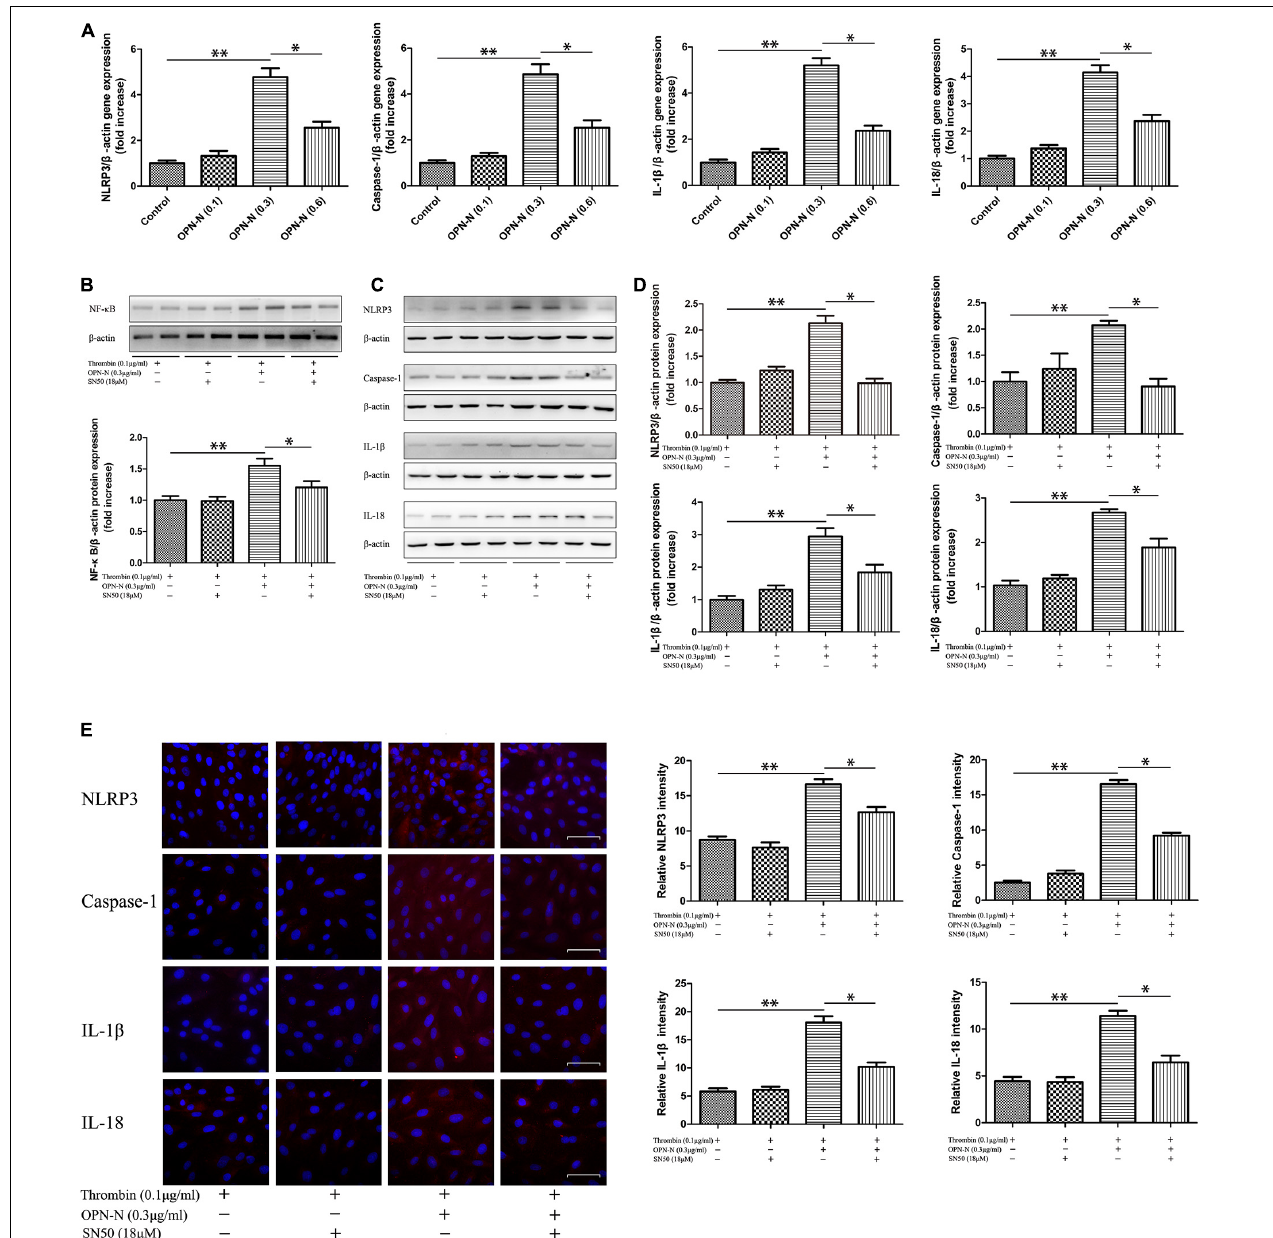
FIGURE 8 | OPN-N had a causal link of pyroptosis and inflammation through NF-KB mediated signaling pathways in VSMCs. (A) qPCR analyses of the mRNA expression level of NLRP3, Caspase-1, IL-1 β , and IL-18 at different OPN-N concentrations. (B) Western blotting analyses of the protein levels of NF- κ B in VSMCs, and quantification of NF- κ B protein expression. (C,D) Western blotting analyses of the protein levels of NLRP3, Caspase-1, IL-1 β , and IL-18 in VSMCs (C) , and quantification of these pyroptosis-related inflammatory factors protein expression (D) . β -actin was used as an internal control. (E) Immunofluorescence staining of NLRP3, Caspase-1, IL-1 β , and IL-18 in mice under different treatments (left), quantification of these pyroptosis-related inflammatory factors area (right). Scar bar 50 µ m. Data are expressed as means ± SEM; n = 3 per group. ∗ P < 0.05 vs the Thrombin + OPN-N + SN50 group; ∗∗ P < 0.05 vs the Thrombin and Thrombin + SN50 groups. Abbreviations: IL, interleukin; NF, nuclear factor; NLRP3, NOD-, LRR-, and pyrin domain-containing protein 3; OPN-N, osteopontin N-terminal